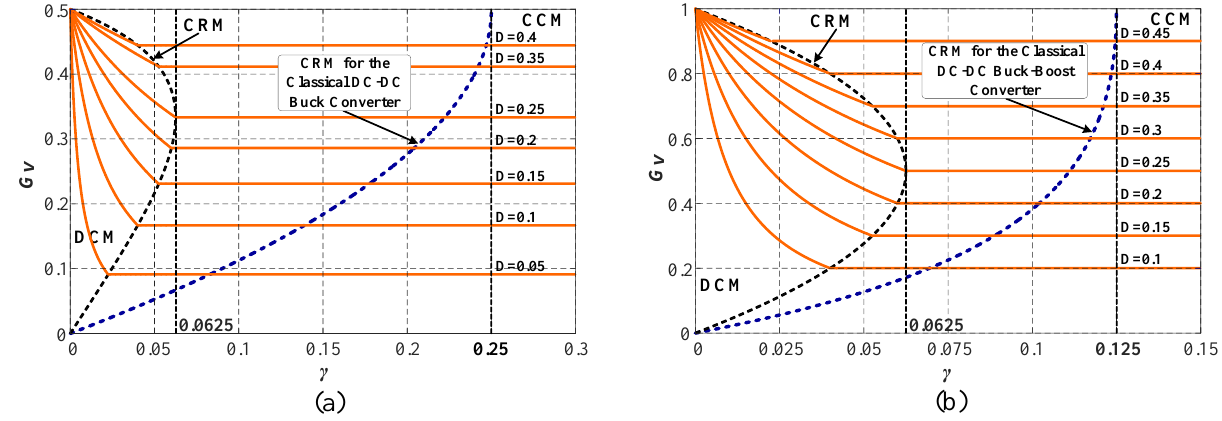
Figure 4. Comparison between the static gain curves of classic converters and 3SSC-A-based step- down converters: ( a ) 3SSC-A-based buck; ( b ) 3SSC-A-based